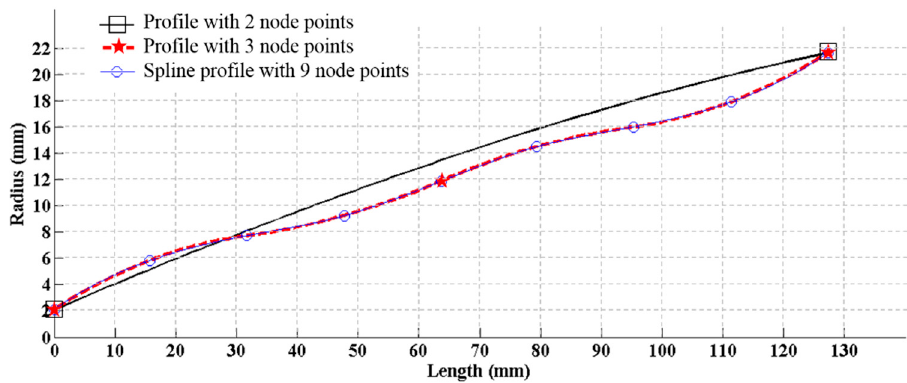
Figure 13. Comparison of profiles with 2 and 3 node points and 9 nodes spline profile horn.